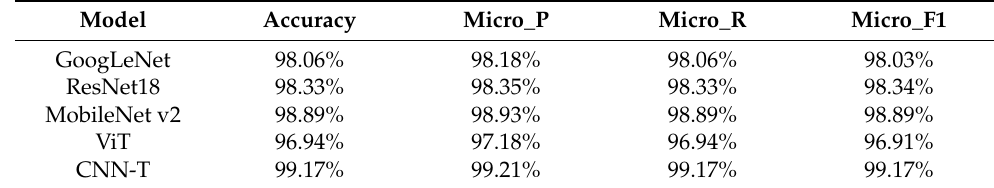
Table 3. Accuracy, precision, recall, and F1 of different models when the training ratio is 80%.